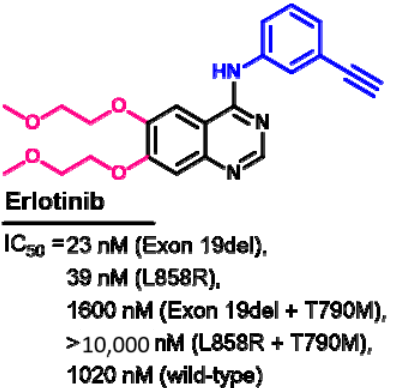
Figure 26. Kinase inhibitory activities of erlotinib.